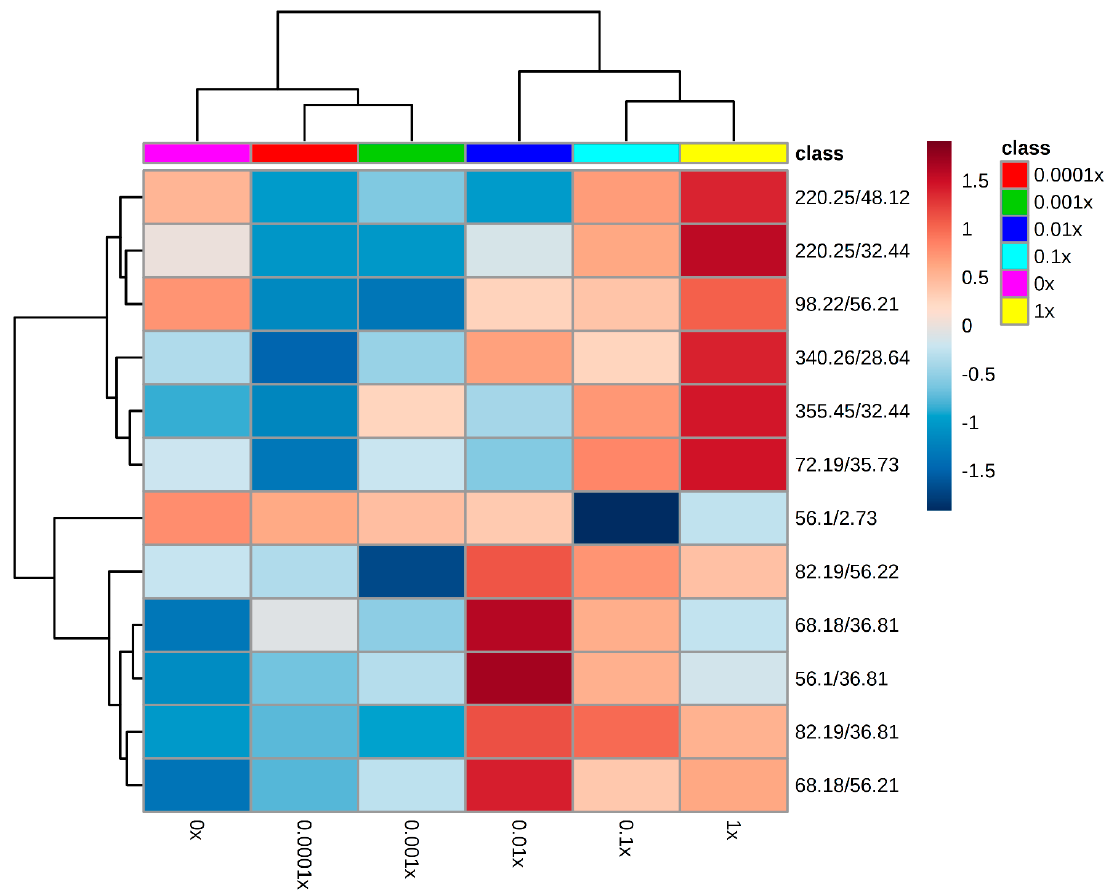
Figure 2. Metabolomic fingerprint of susceptible Avena fatua L. plants ( n = 4) at 24 h after been sprayed with clodinafop-propargyl in proportional doses of the recommend rate (1x, 0.1x, 0.01x, 0.001x, 0.0001x, and 0x). The heatmap was constructed with the 12 metabolites that showed p - and q - values ≤ 0.05. Colors represent the abundance of metabolites; the blue color indicates down-expression and red color over-expression. The metabolites are clustered according to their Pearson correlation as a distance function, and the Ward clustering algorithm, the significance of the branches were of p ≤ 0.05.